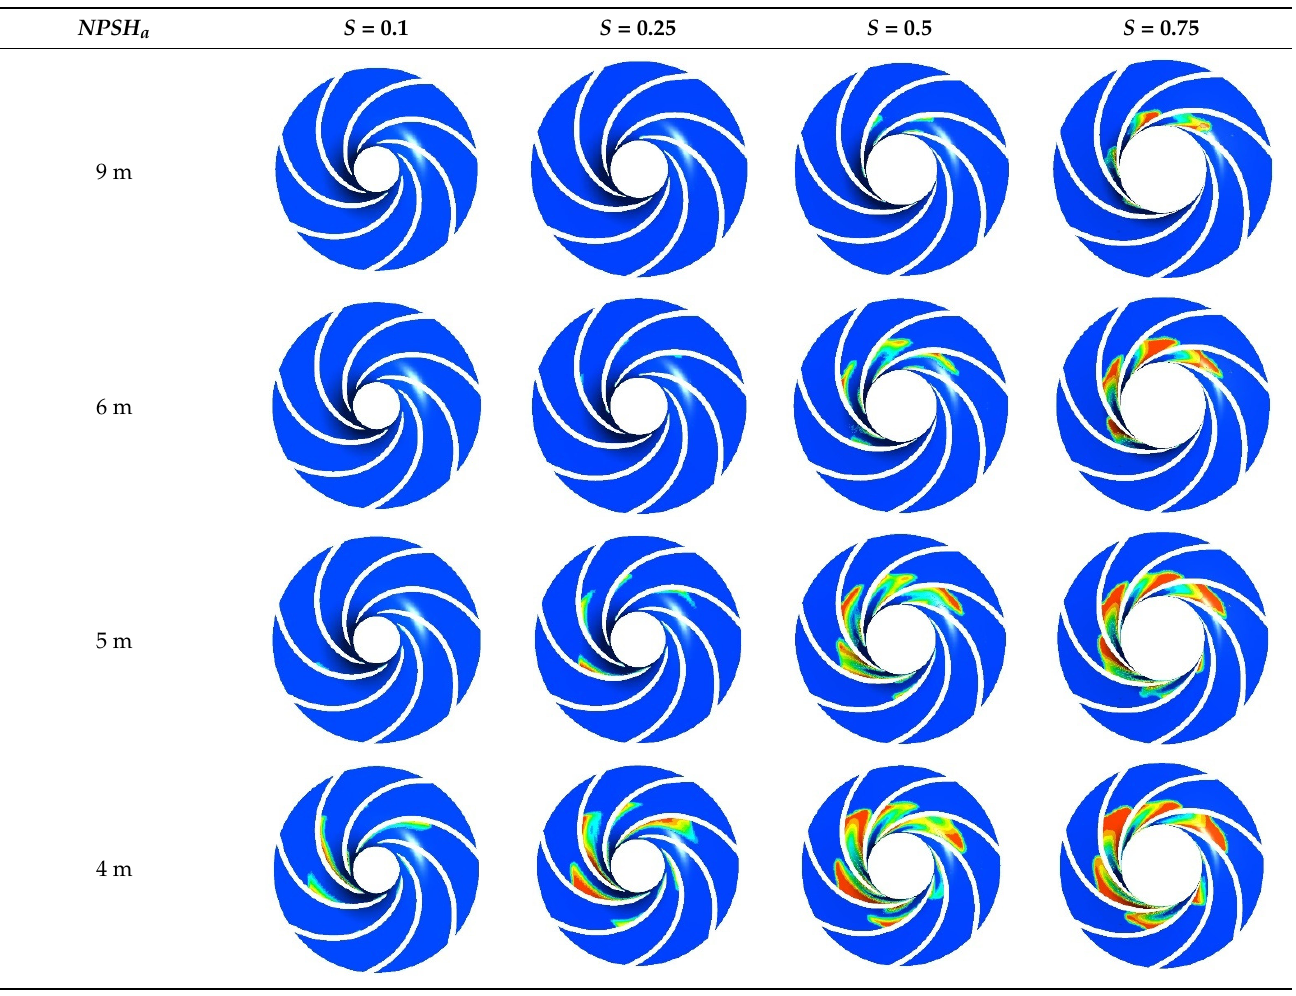
Table 4. Bubble volume fraction in the primary impeller.